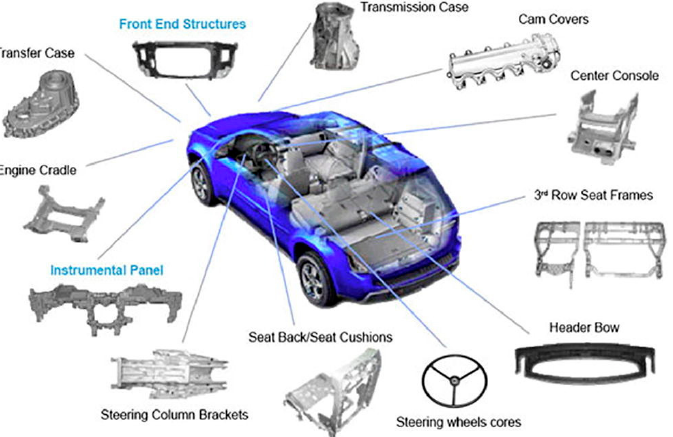
Figure 2. Use of magnesium-based materials in the automotive industry. Reproduced with permission from Sankaranarayanan, S. and M. Gupta (2021). “Emergence of god’s favorite metallic element: Magnesium based materials for engineering and biomedical applications.”; published by Elsevier, 2021 [54].